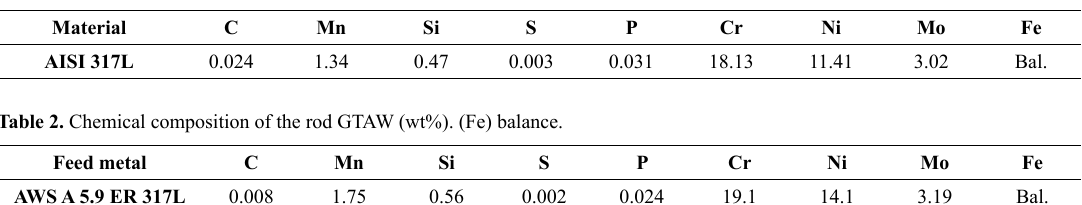
Table 1. Chemical composition of the base metal (wt%). (Fe) balance.